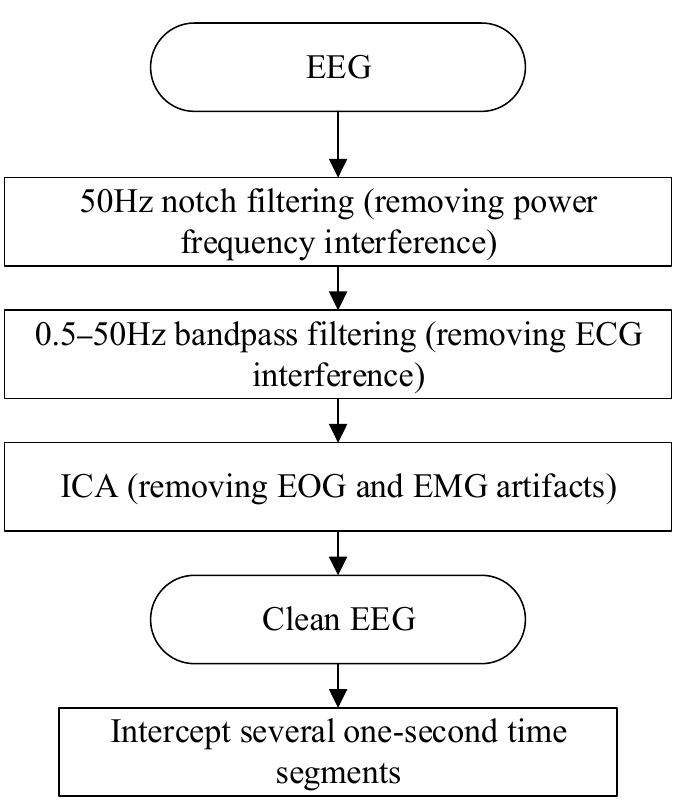
Figure 2. EEG preprocessing